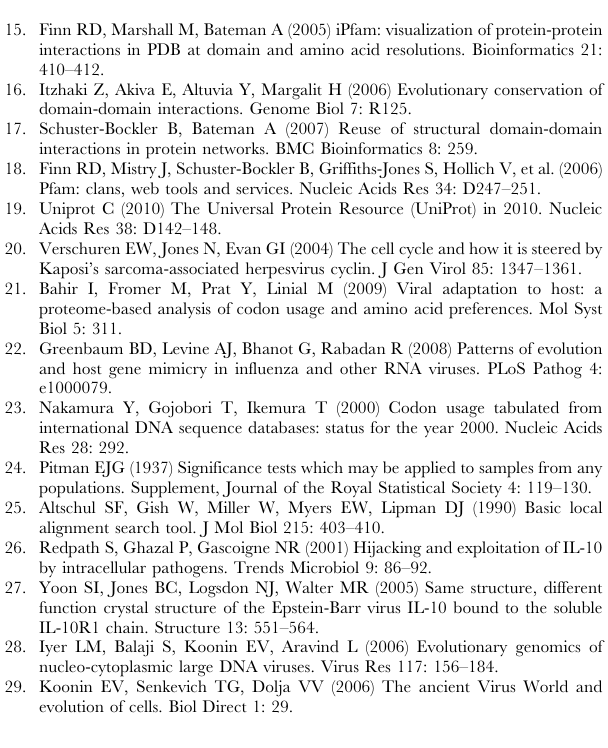
Figure S1 Distributions of fractions of PPIs attributed to DDIs in the random networks. The fractions in the actual networks are written in the upper right box in each graph. (TIF) Dataset S1 The domain-pairs that potentially mediate the human-virus and intra-virus PPIs.